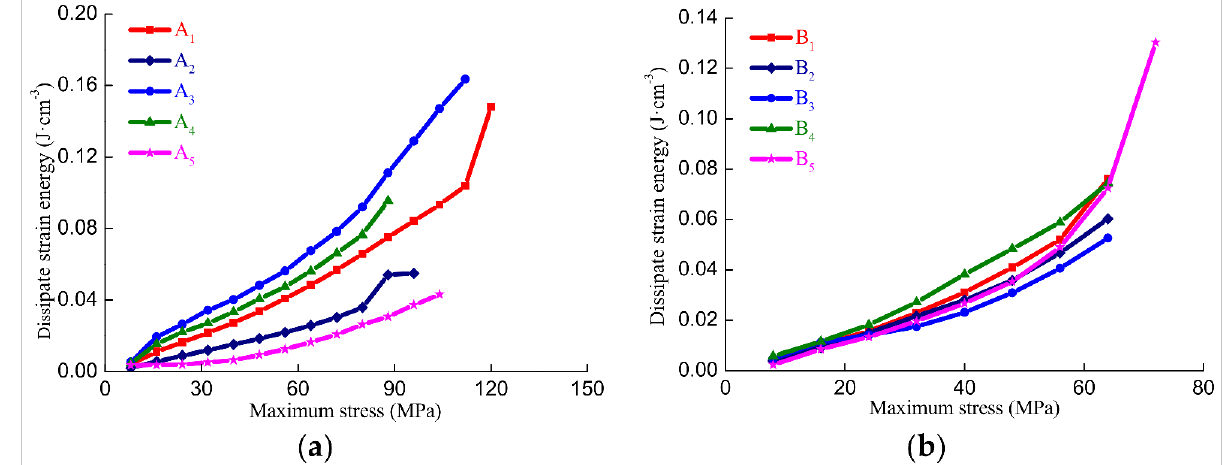
Figure 5. Dissipative strain energy during cyclic loading and unloading of sandstone. ( a ) Dry rock samples. ( b ) Saturated rock